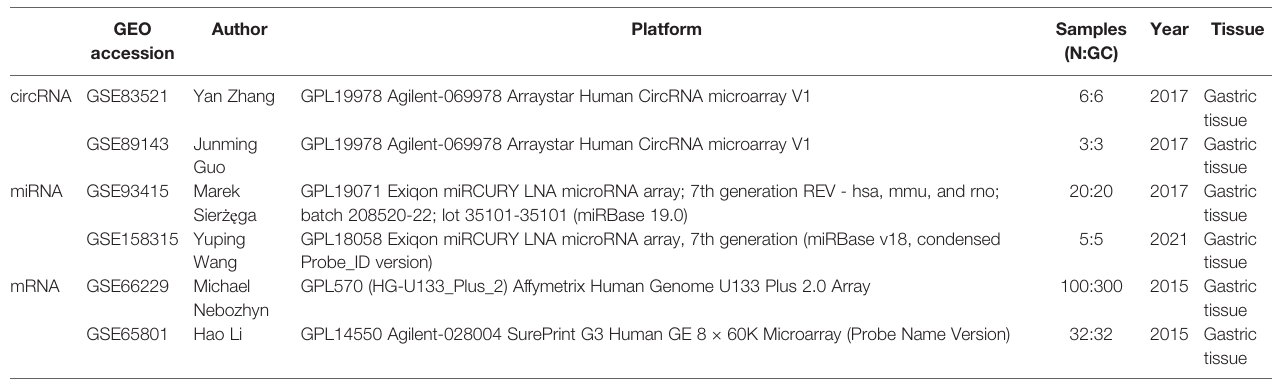
TABLE 1 | Detailed information of selected datasets of circRNA, miRNA, and mRNA expression datasets. GEO